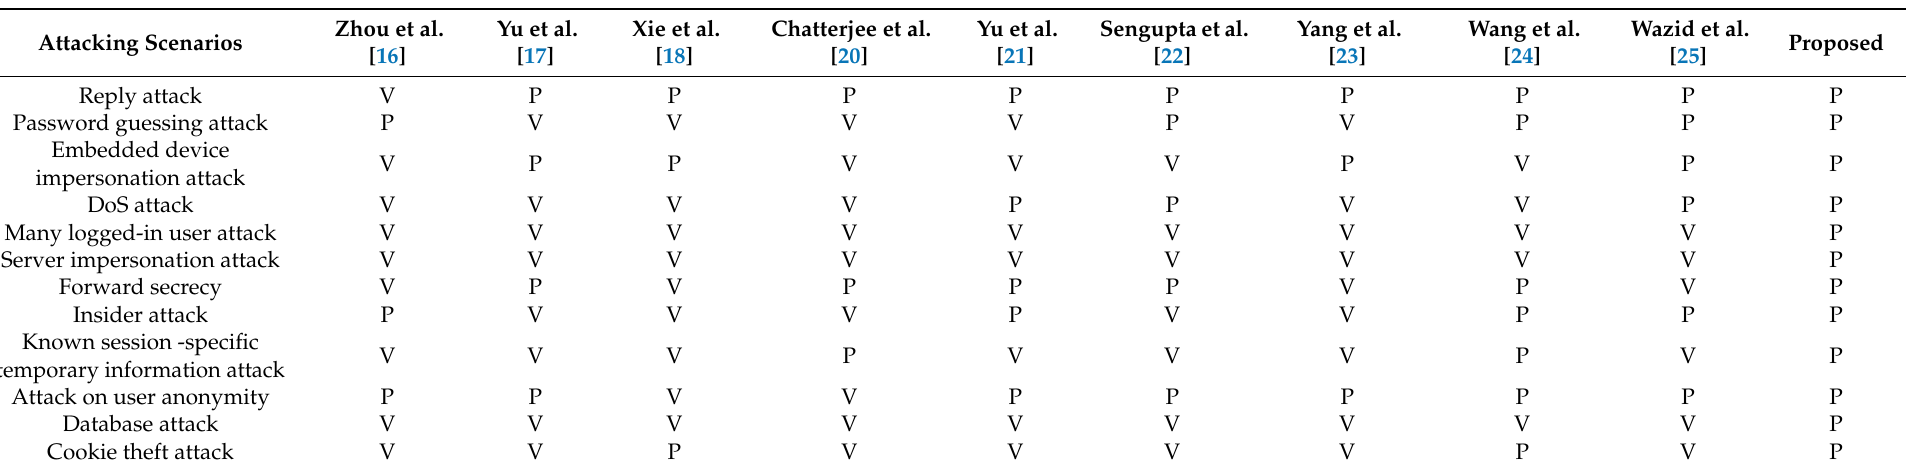
Table 2. Comparison by types of security